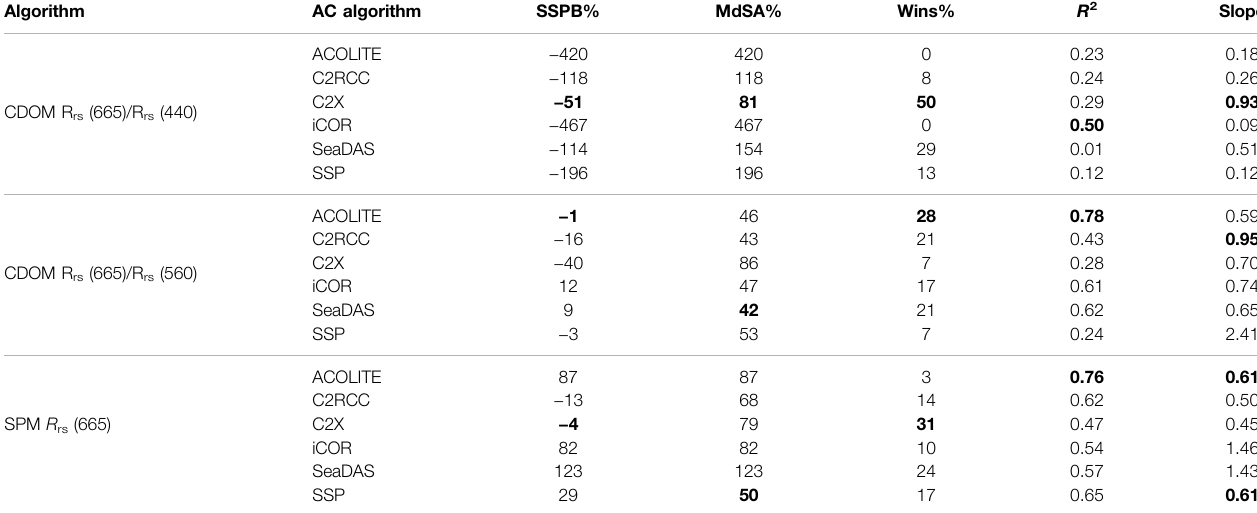
TABLE 3 | Performance metrics of atmospheric correction algorithms for CDOM and SPM retrieval. For CDOM, only the algorithms for a g (440) were tested ( fi rst two lines in Table 1 ). Numbers in bold font highlight the best atmospheric correction. Algorithm